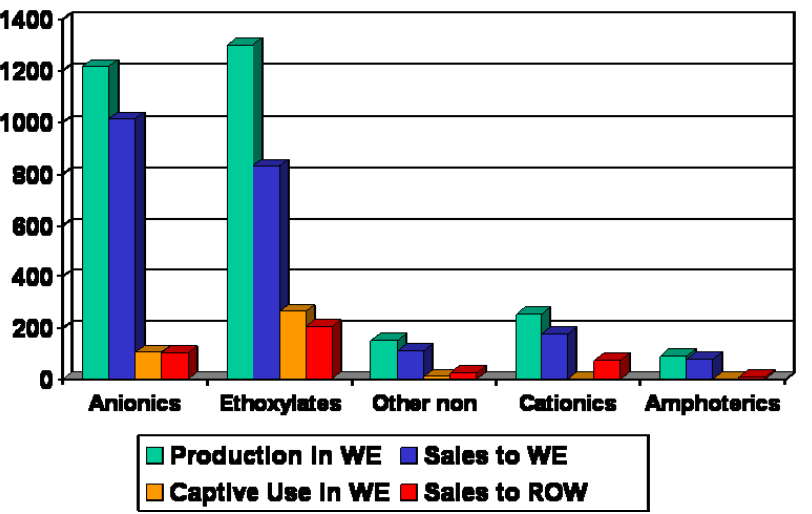
Figure 1. Surfactants 2007 in Western Europe (WE) and Rest of the World (ROW): 3 mio tons